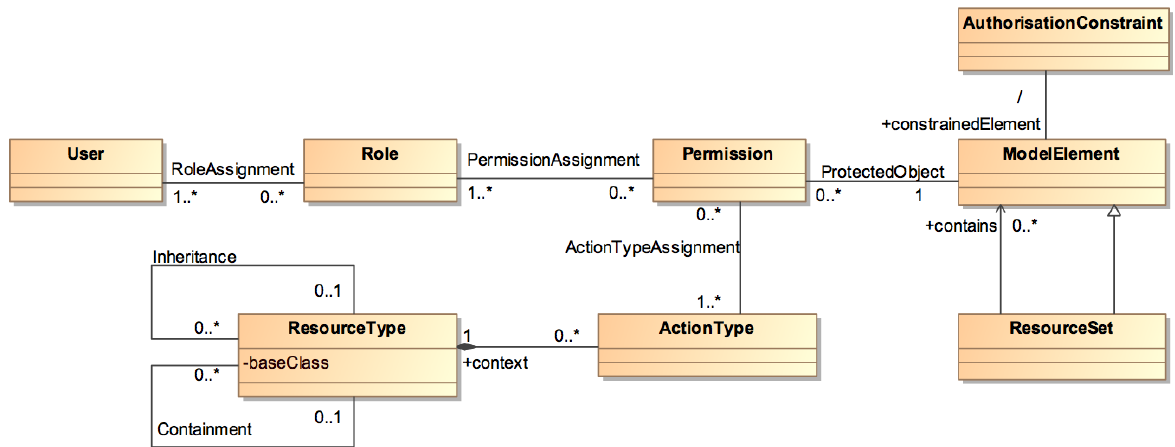
Figure 2. SecureUML meta-model (adapted from [4] and [25])